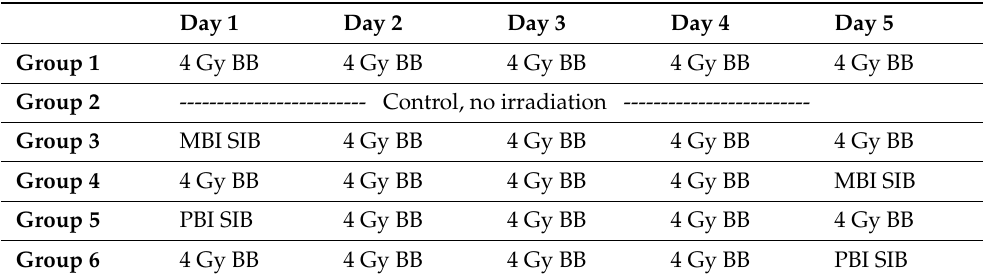
Table 1. Overview over the experimental groups and the treatment administered. BB: low dose rate broad beam irradiation; MBI: monoplanar microbeam irradiation; PBI: pencilbeam irradiation; SIB: simultaneously integrated